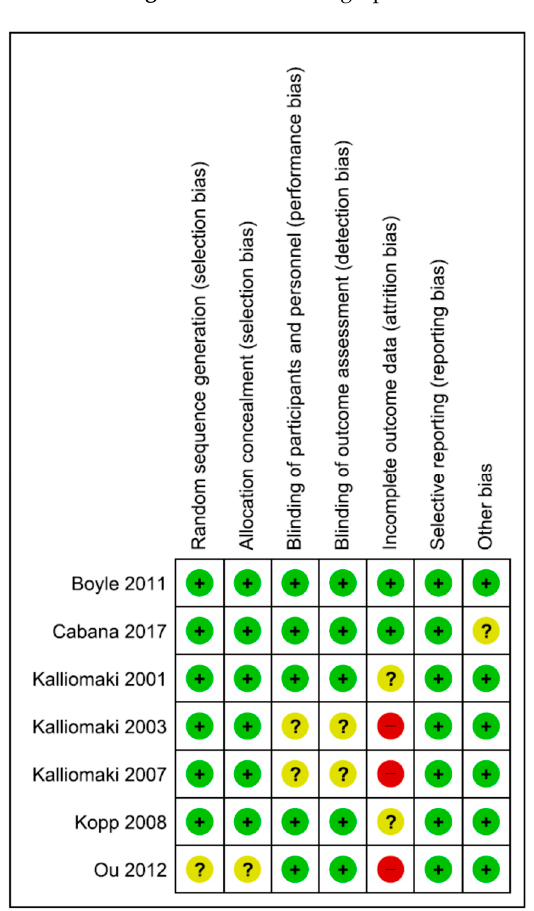
Figure 2. Risk of bias summary.